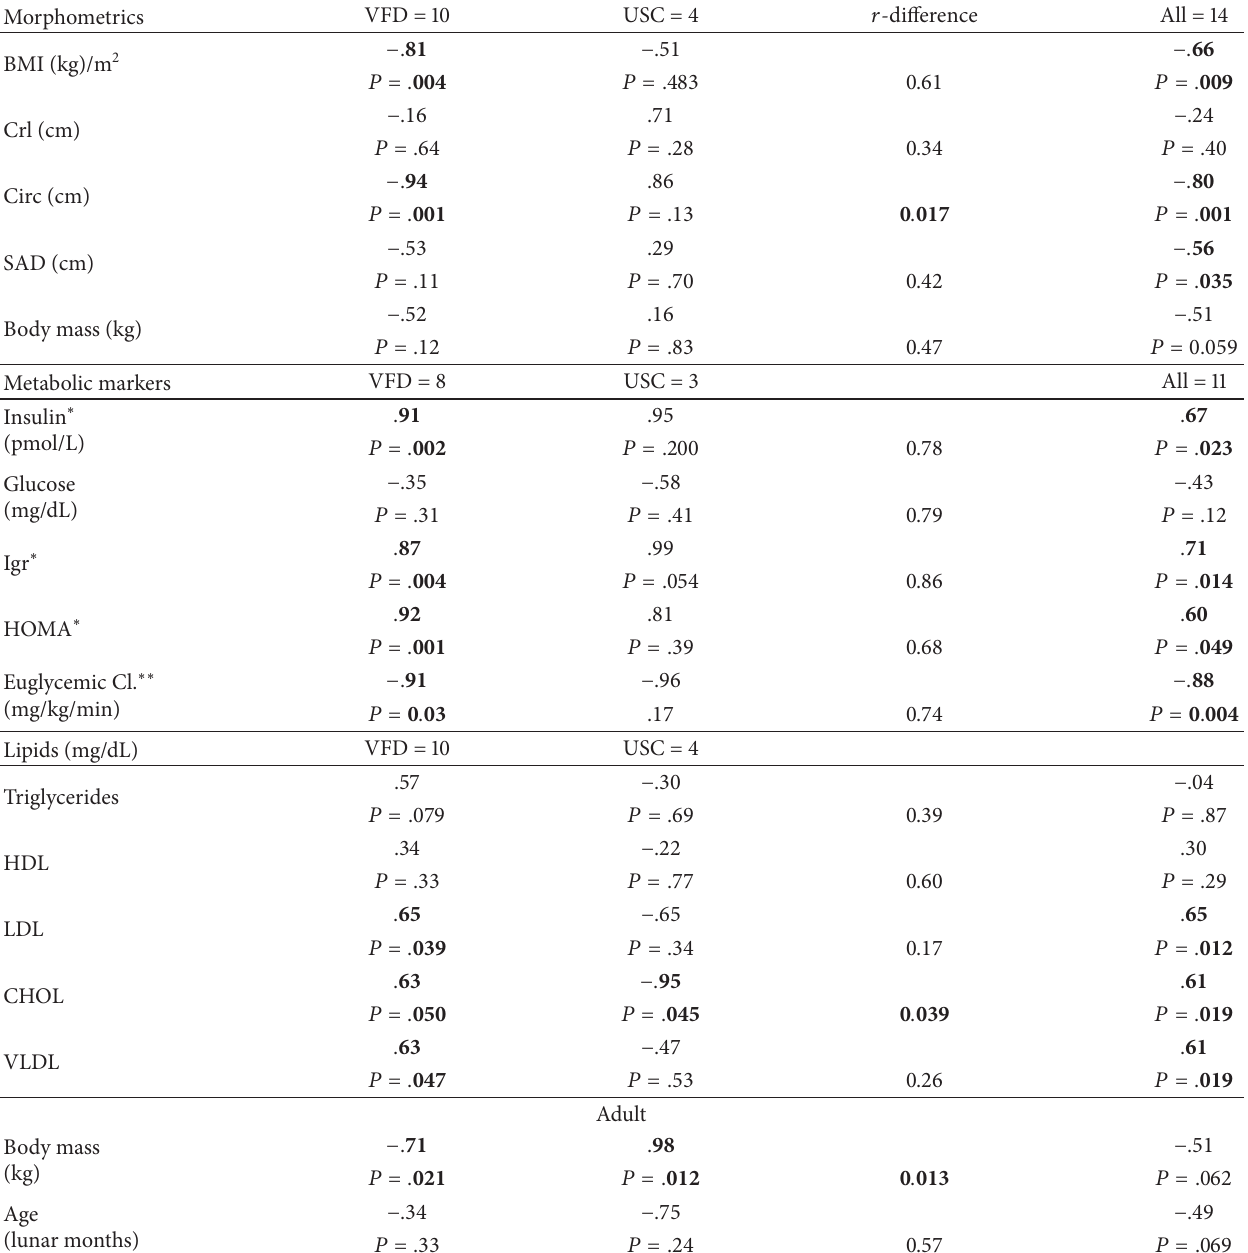
Table 2: Comparison of within-rearing group and combined subjects Pearson correlations between adolescent GLP-1 and morphometrics, metabolic markers, and plasma